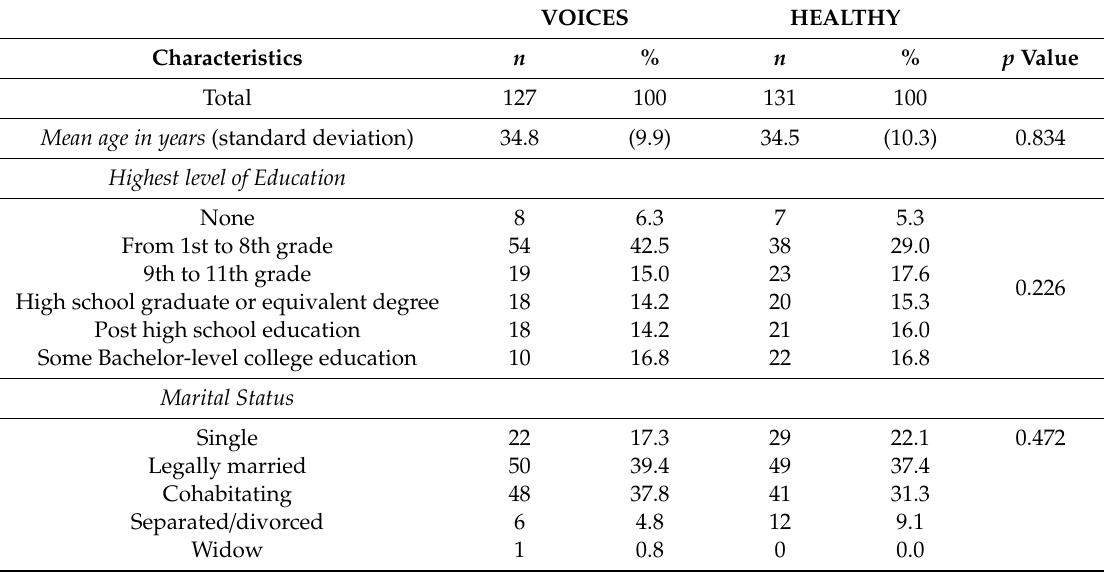
Table 1. Baseline characteristics between participants from VOICES and HEALTHY, South Florida,